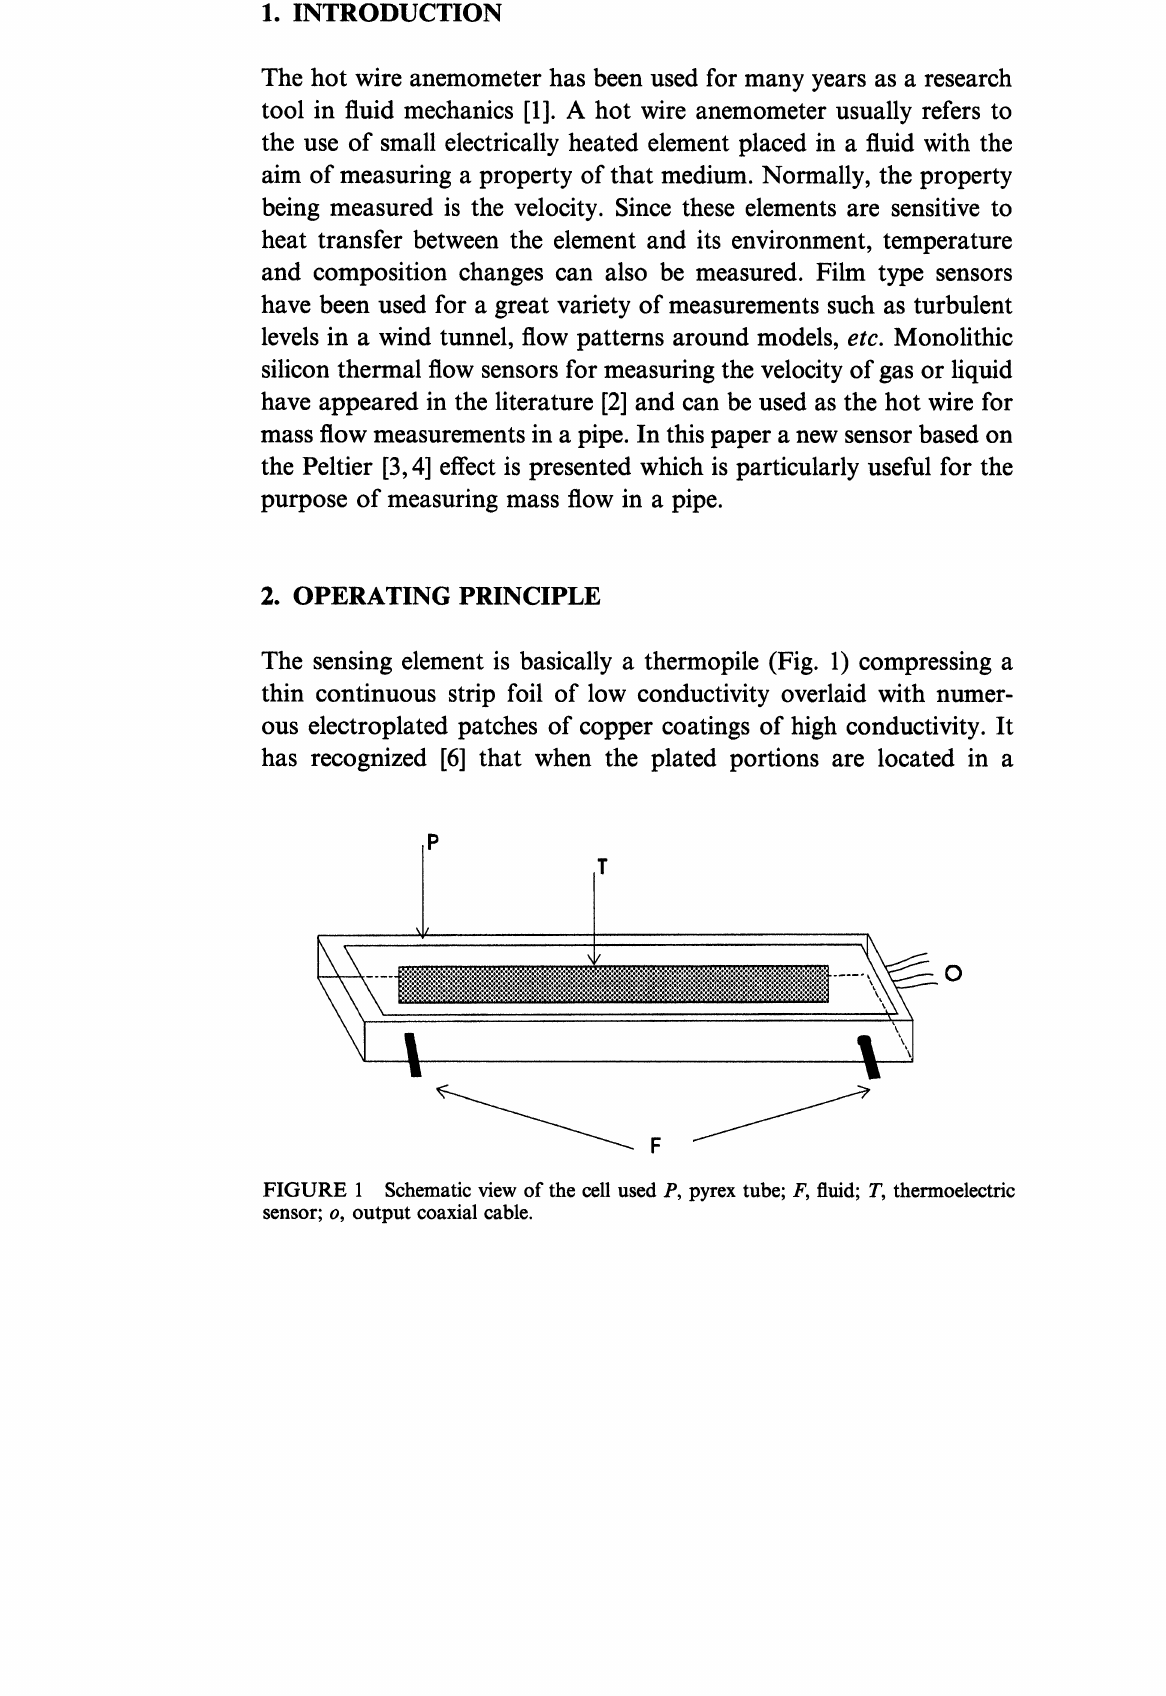
FIGURE Schematic view of the cell used P, pyrex tube; F, fluid; T, thermoelectric sensor; o, output coaxial